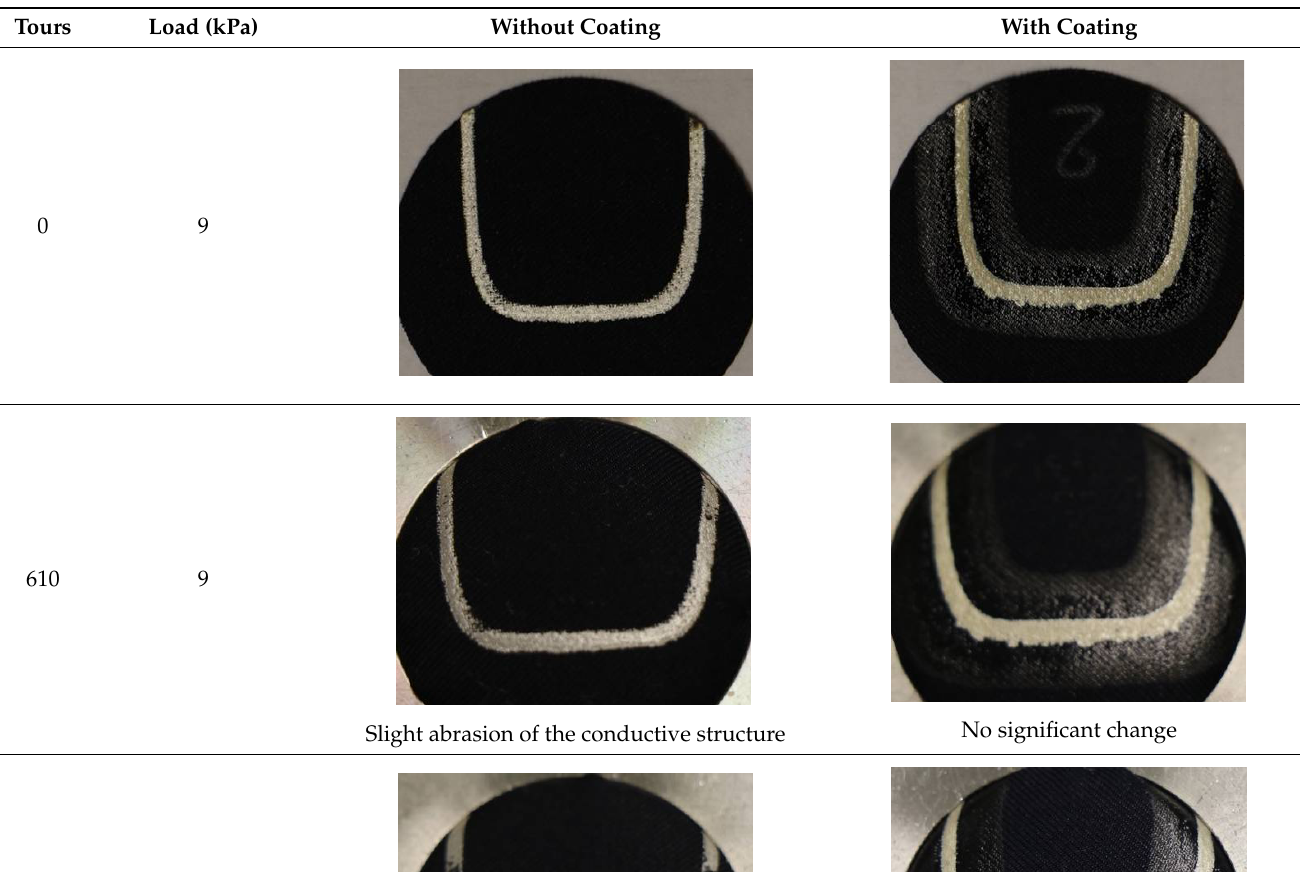
Table 5. Influence of a coating once printed on a conductive structure.